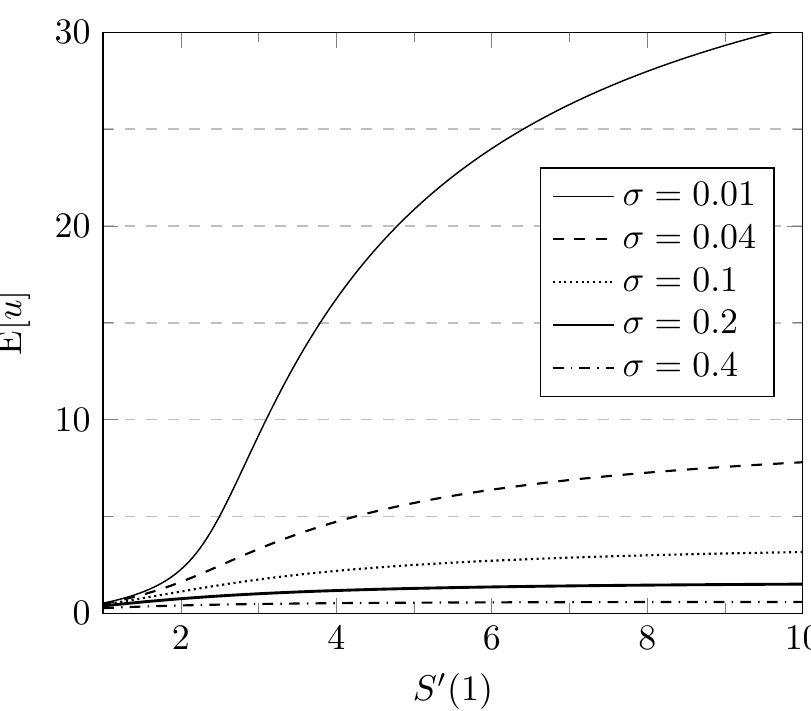
Figure 6. Mean system content E [ u ] versus S (cid:48) ( 1 ) for Poisson service times, Poisson arrivals with λ = 0.4 and different values of σ .